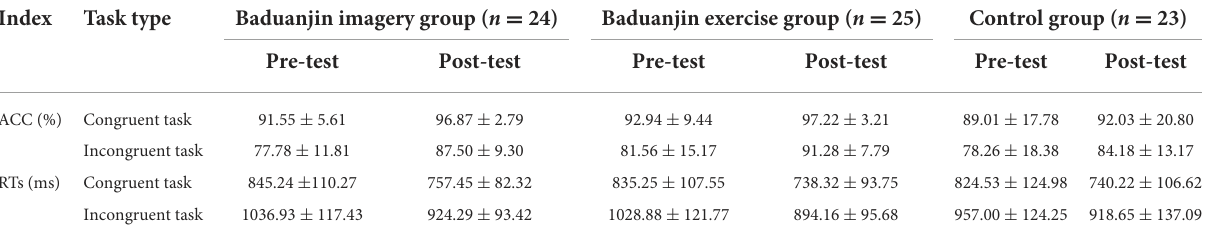
TABLE 3 The ACC (%) and RTs (ms) on the Stroop task (M ±